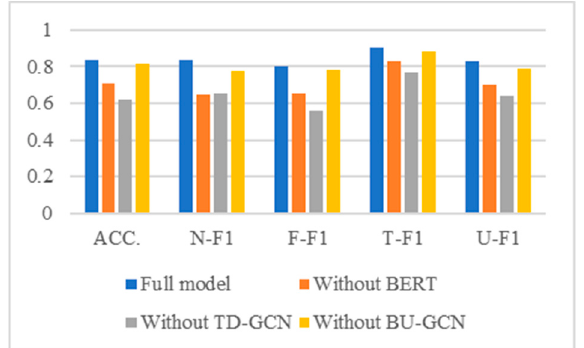
Figure 5. Results of the ablation experiments on Twitter15.